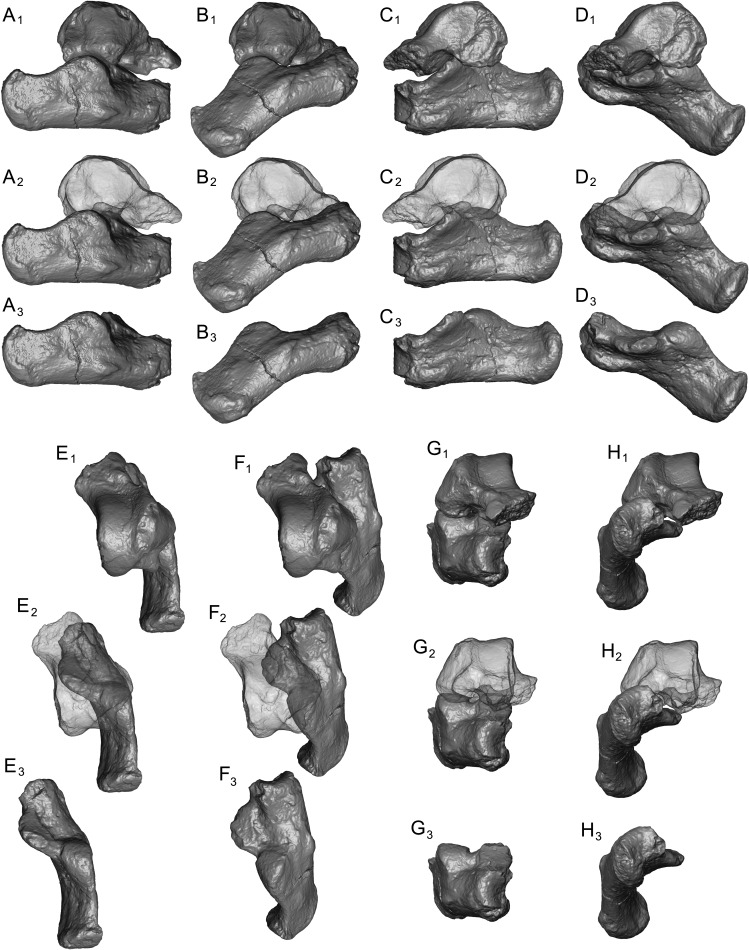
Articulation of the unassociated Caenopithecus astragalus NMB En.270 and and calcaneus NMB Eh 719 in inversion and eversion.Articulated astragalus and calcaneus in (A) lateral view, inverted; (B) lateral view, everted; (C) medial view, inverted; (D) medial view, everted; (E) dorsal view, inverted; (F) dorsal view, everted; (G) distal view, inverted; (H) distal view, everted. In each unique view, from top to bottom the astragalus is rendered as solid (e.g., A1), translucent (e.g., A2), or is not shown (e.g., A3).